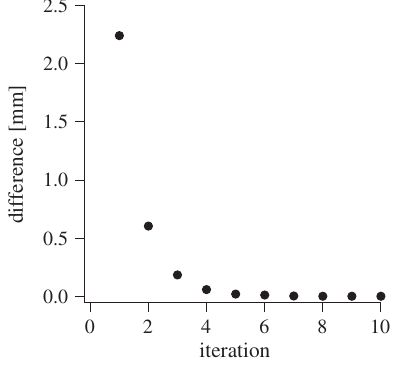
FIG. 4. Iterative process to determine the self consistent position of the beamlets. The vertical axis describes the distance of a beamlet ’ s position from the closed orbit found after particle tracking including